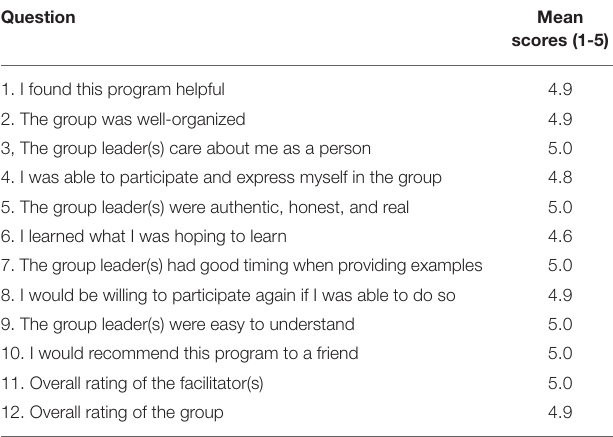
TABLE 3 | Number of sessions completed by participants ( n = 30). Number of sessions